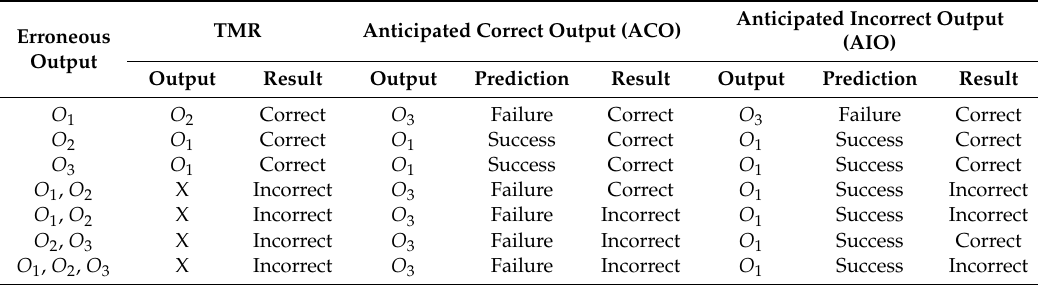
Table 1. All error cases in the triple modular redundancy (TMR) and Prediction-based Error Correction (PRECOR) methods when retaining di ff erent